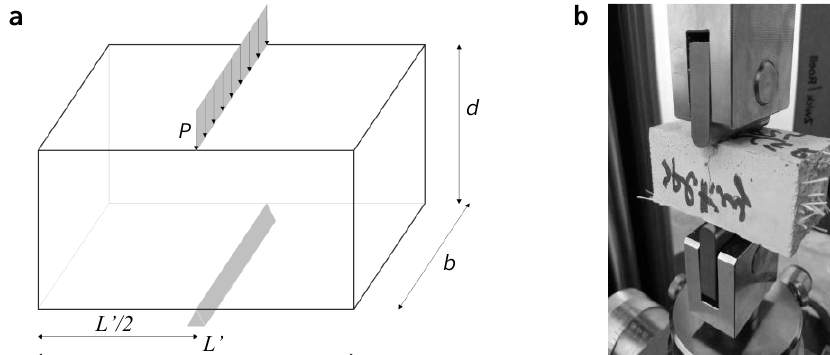
Figure 3. ( a ) scheme employed for the Brazilian test (BT); ( b ) picture of the BT carried out at the LPMS of